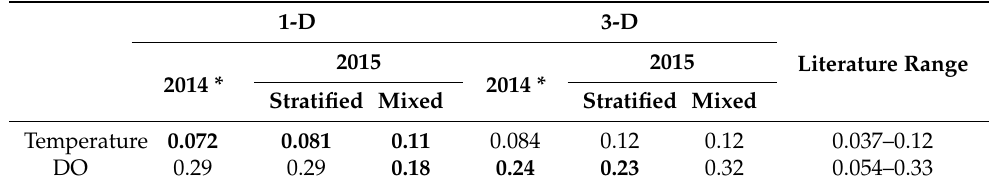
Table 5. The whole-lake normalized mean absolute error (NMAEs) of the predicted temperature and DO for 2014 and 2015. The literature range [8,9,49] is shown in the last row. The relatively lower NMAEs between the 1-D and 3-D model results are shown in bold.